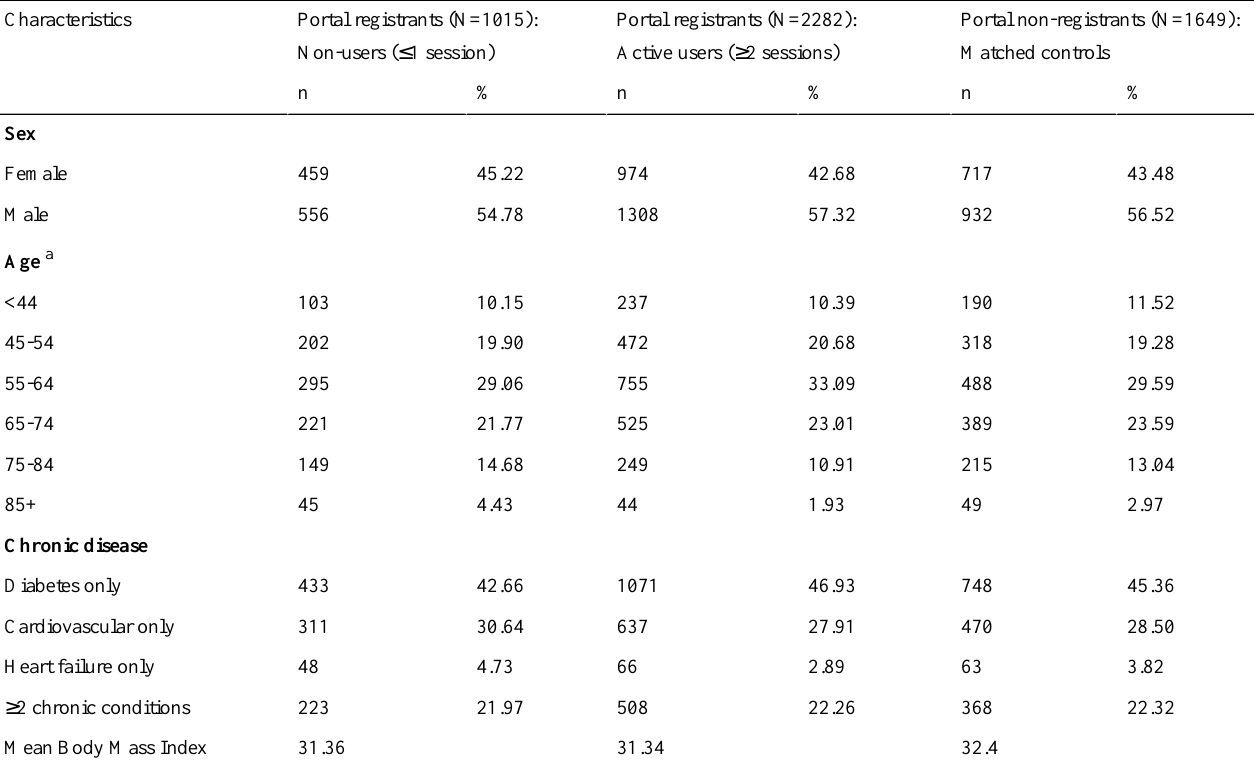
Table 2. Characteristics of Web portal registrants who access the site at least 2 times compared with non-registrants and registrants who used the site minimally.